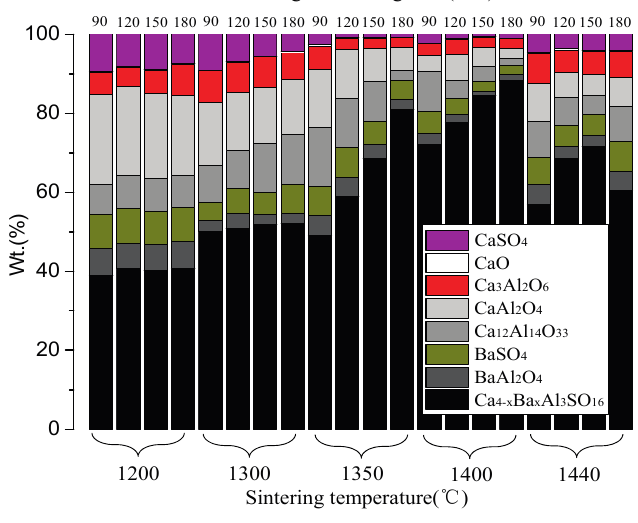
Figure 3. Results of quantitative analysis.